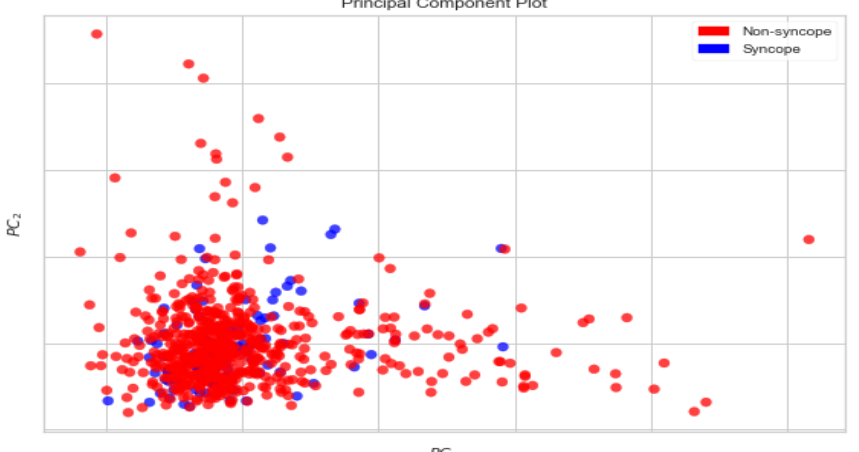
Figure 7. 2-Dimensional Plot of First Two PCs.